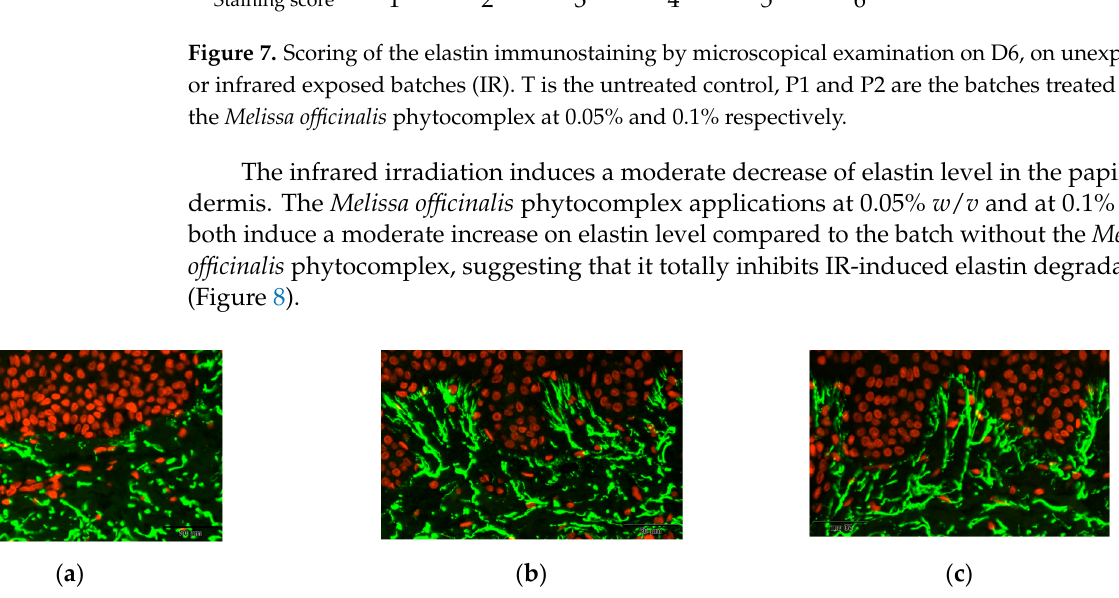
( c ) Figure 10. MMP-1 immunostaining in the papillary dermis of the batches irradiated with infrared on D6 ( a ), irradiated with infrared, and pre-treated with the Melissa officinalis phytocomplex at 0.05% ( b ) or 0.1% w/v ( c ) on D6. T P1 P2 IR P1IR P2IR Staining score